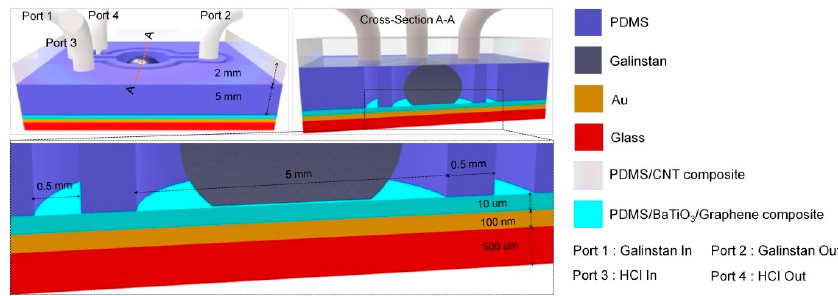
Figure 7. Structure of the reduced Galinstan-based microfluidic energy harvester.